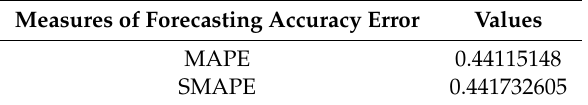
Table 5. Goodness of fit of the model. SMAPE, Symmetrical MAPE.